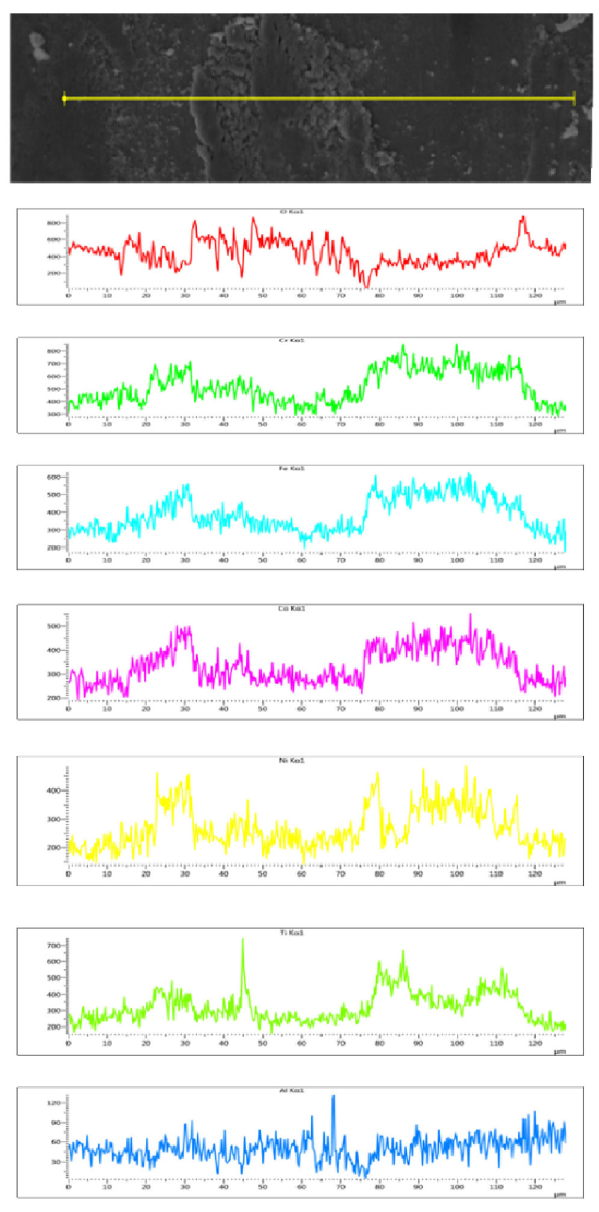
Fig. 10 EDS analysis of wear particles from the CoCrFeNiTi 0.5 Al 0.5 alloy at 500 ° C.